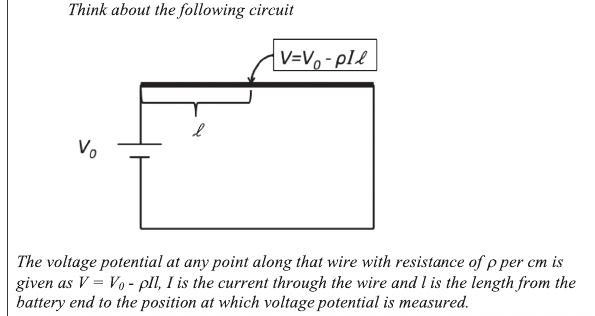
FIG. 5. The prompt given to Judy for the extended resistor